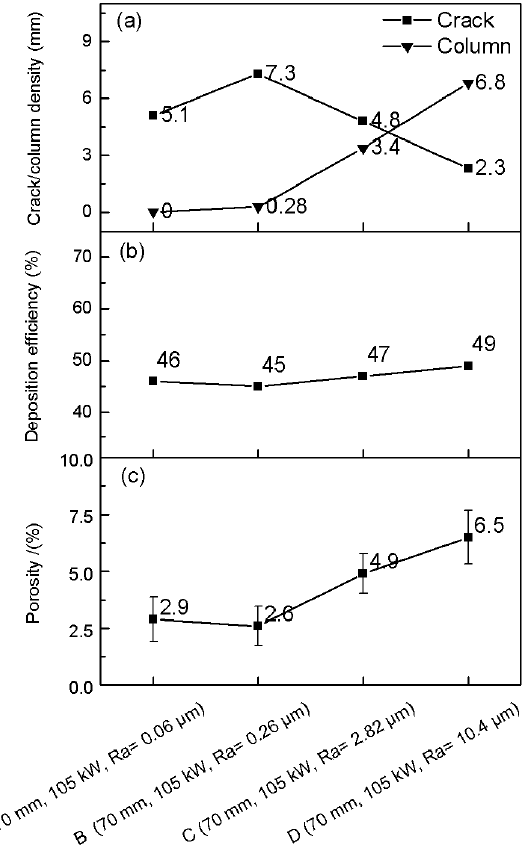
Figure 2. Crack/column density ( a ), deposition efficiency ( b ), and porosity ( c ) for as-sprayed YSZ top coats (Samples A, B, C, and D) deposited on BC with different surface treatments.